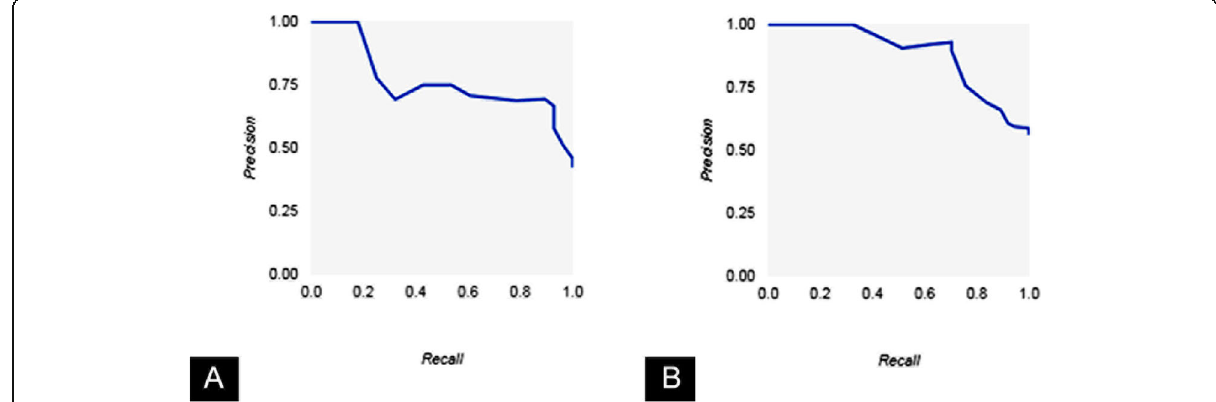
Fig. 3 Precision-recall tradeoff graphs for classification of “ Normal ” ( a ) and “ Pathology ” ( b )